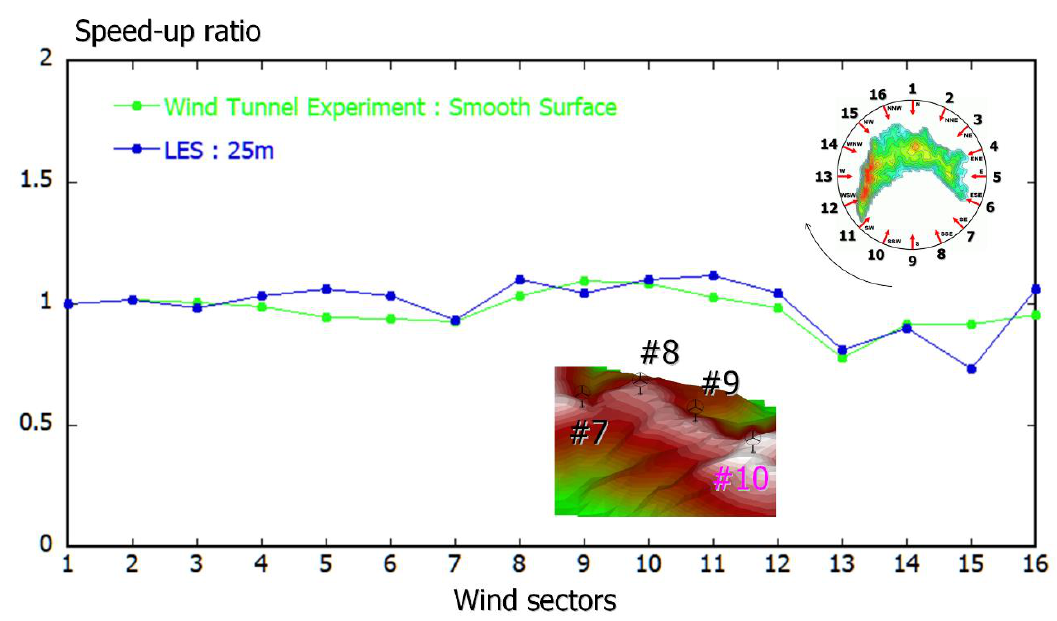
Figure A10. Comparison of local speed-up ratios at WT #10 hub height obtained by wind tunnel experiments and numerical simulations for 16 wind sectors.